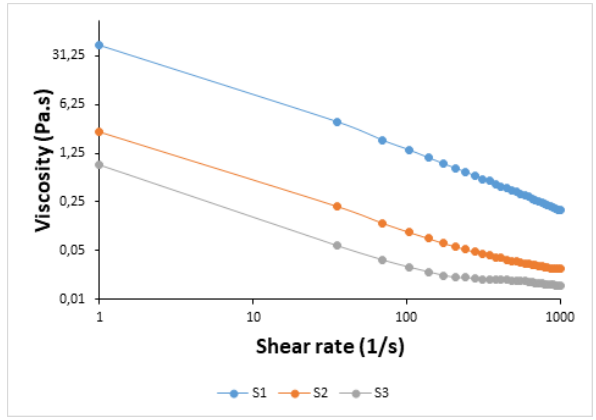
Figure 2: The effect of rate of shear on the dust viscosity (log-log scale) (sample S1: untreated phosphate dust, sample S2: calcium phosphate dust from the outside of filter and sample S3: calcium phosphate dust from the inside of filter)